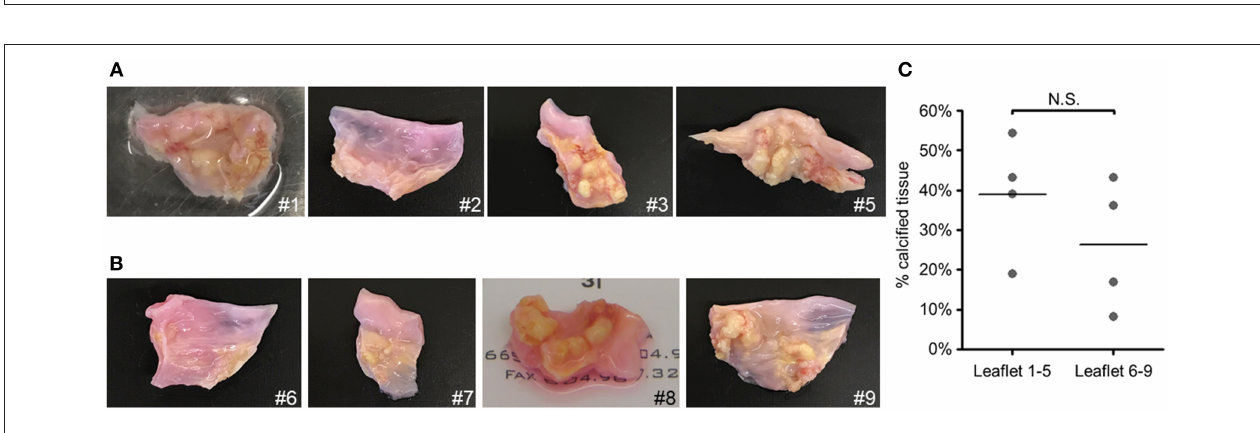
absent from the same clusters of calcification-resistant VICs ( Figure 5B ): sodium/potassium-transporting ATPase subunit beta-1 (ATP1B1), GFAP, family with sequence similarity 234 member A (ITFG3), laminin subunit beta 2